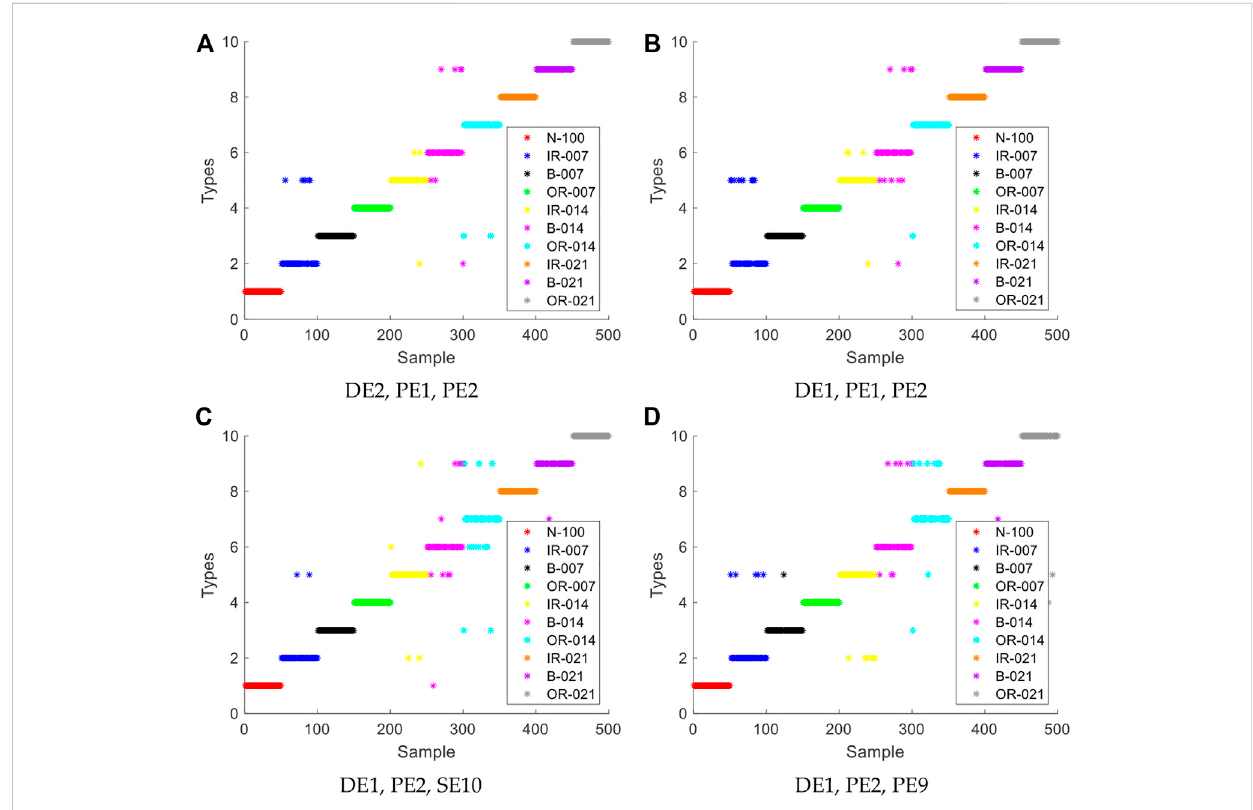
FIGURE 6 Triple feature recognition results for ten types of signals: (A) DE2, PE1, PE2 ; (B) DE1, PE1, PE2; (C) DE1, PE2, SE10; (D) DE1, PE2,